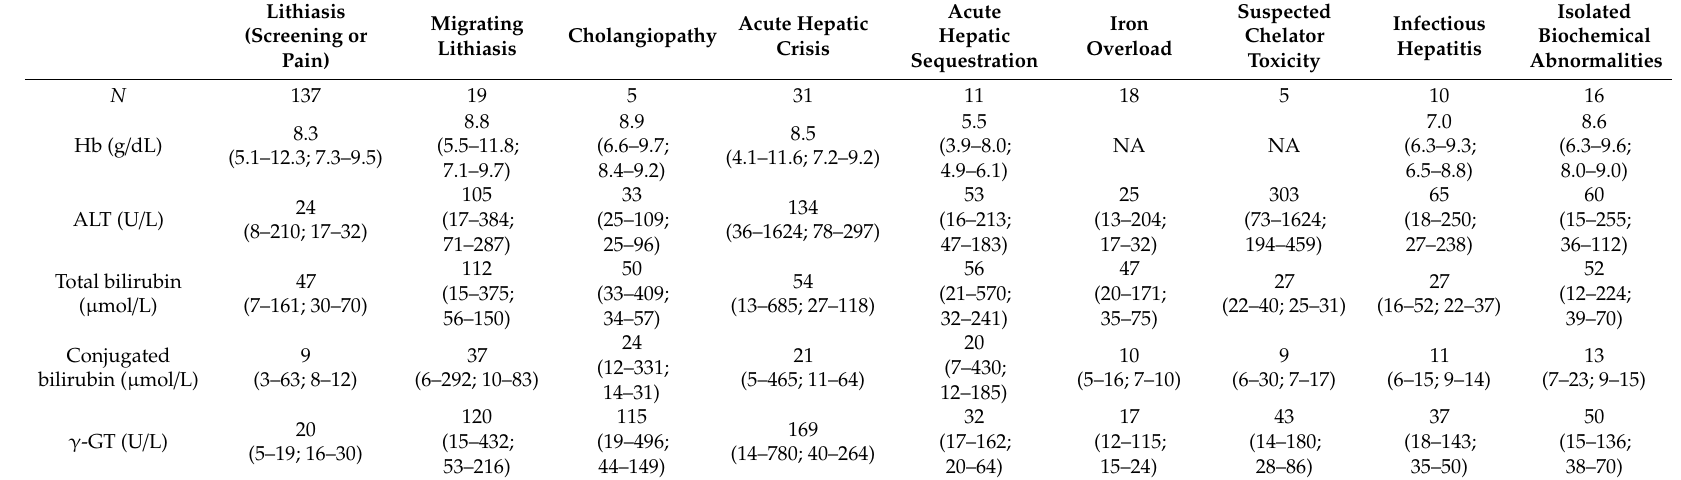
Table 2. Biological characteristics of patients with hepatobiliary